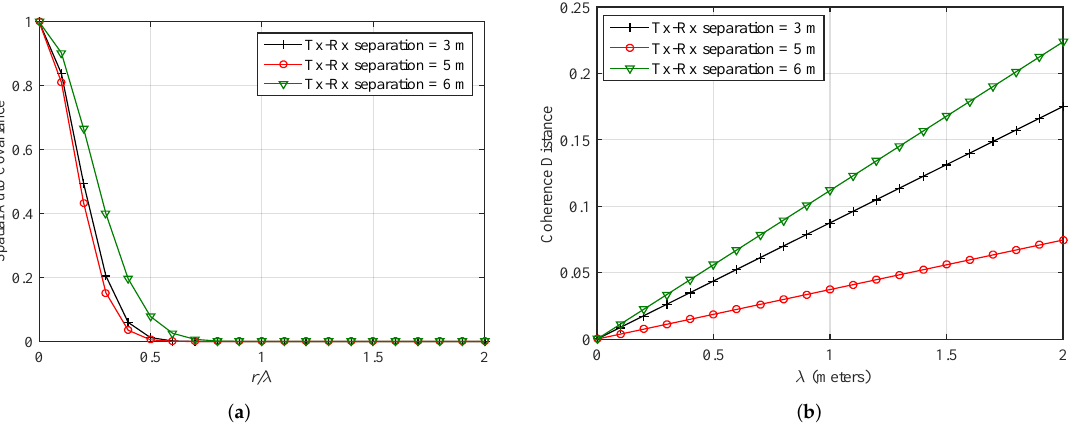
Figure 9. Spatial auto-covariance and CD for different scenarios of indoor mmWave (Case 2 (b); 38 GHz) radio propagation environments in ( a , b ), respectively. ( m = 1, f d = 10